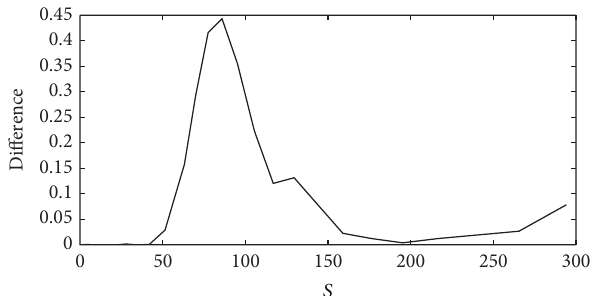
Figure 4: Difference between Black-Scholes model and Barles- Soner model.